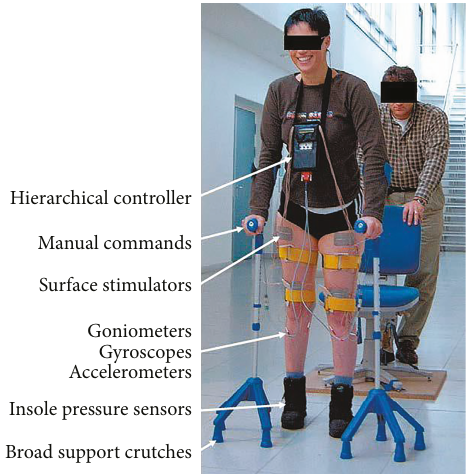
Figure 3: Functional electrical stimulation (FES) research system for paraplegic locomotion, adapted from